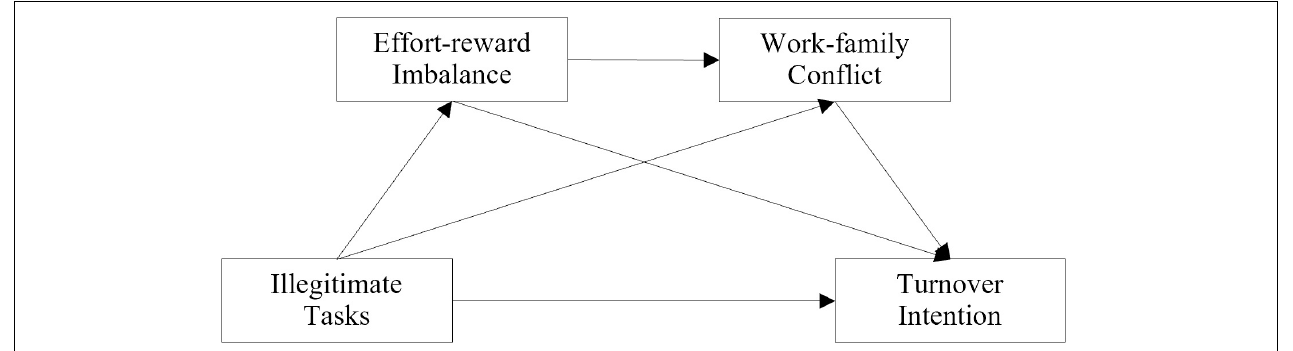
FIGURE 1 | Research model.